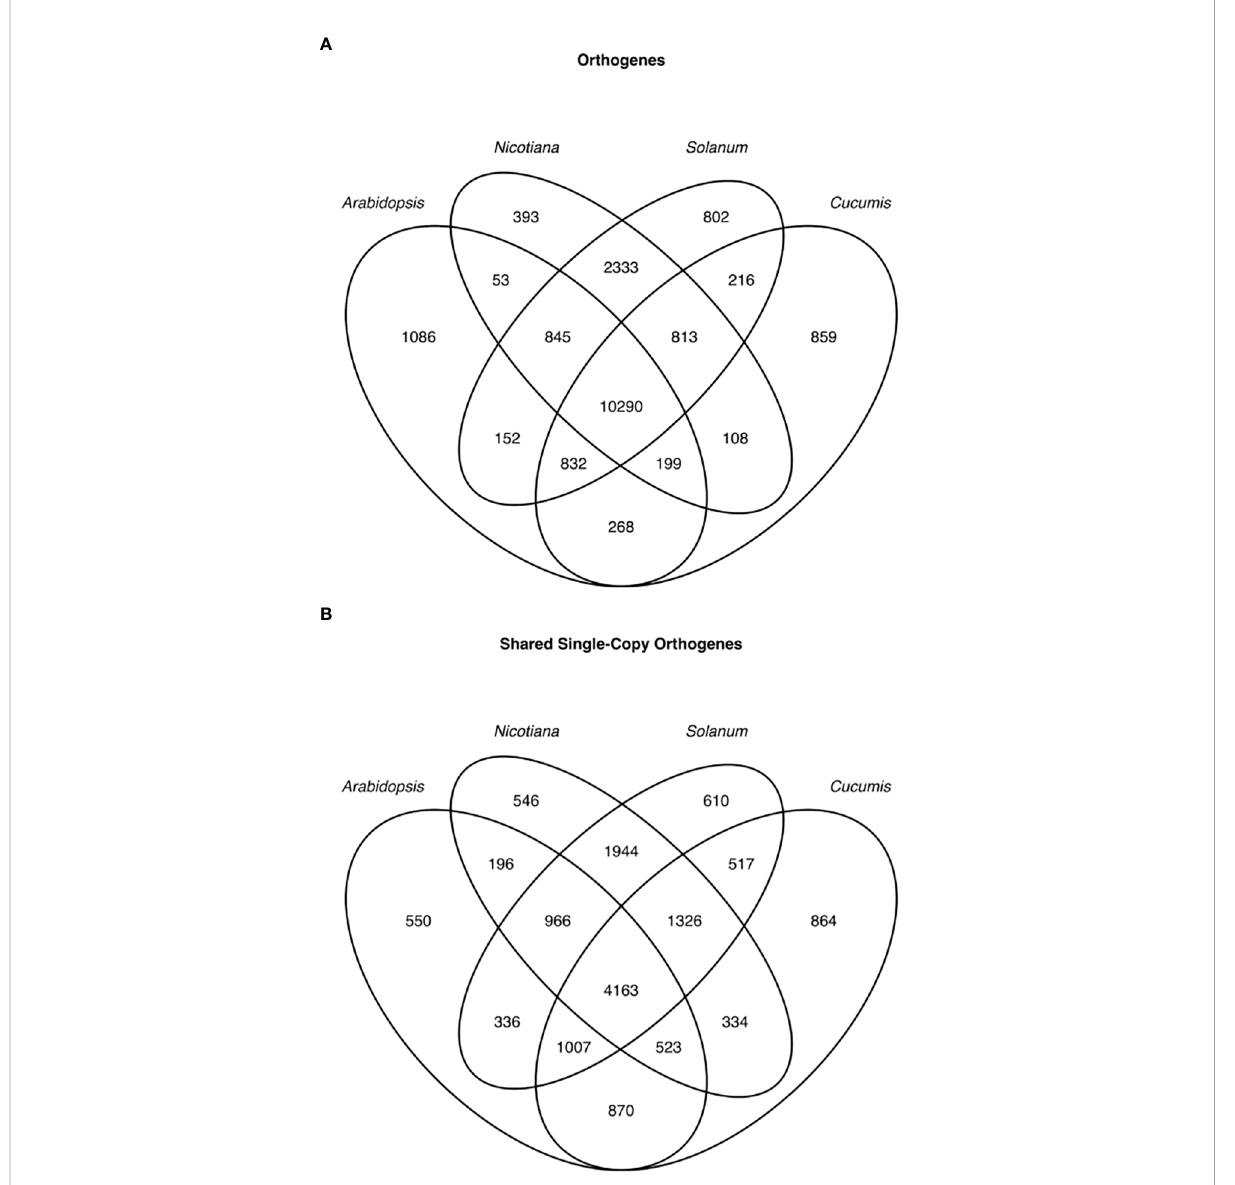
FIGURE 6 Venn diagram of orthologous genes (orthogenes) among the 4 genera used in this study. All genes across the 4 genera (A) and only single-copy genes (B)